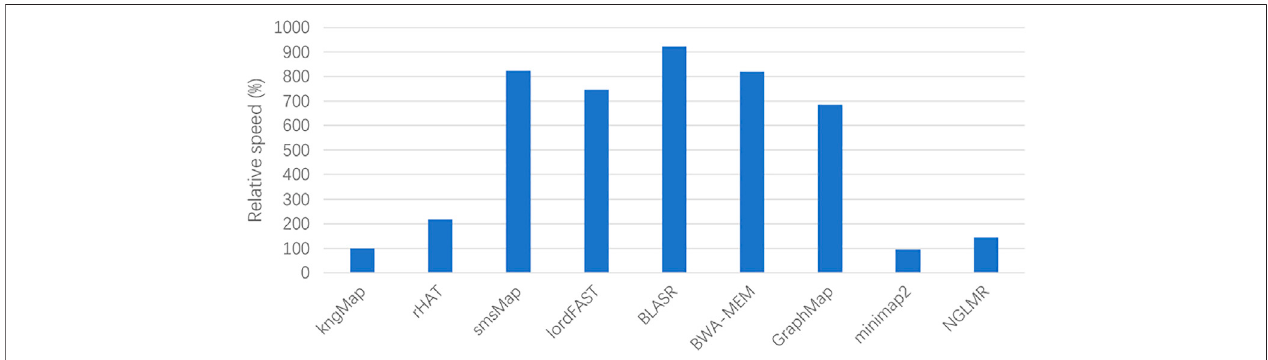
FIGURE 5 | Relative speed of the aligners benchmarking on the real H . sapiens datasets. The relative speed of one mapper is de fi ned as T (aln)/ T ( kngMap ), where T ( aln )and T ( kngMap )arethealignmenttimesofacomparedalignerandkngMap,respectively.Thelowertheheightofthebar,thefaster